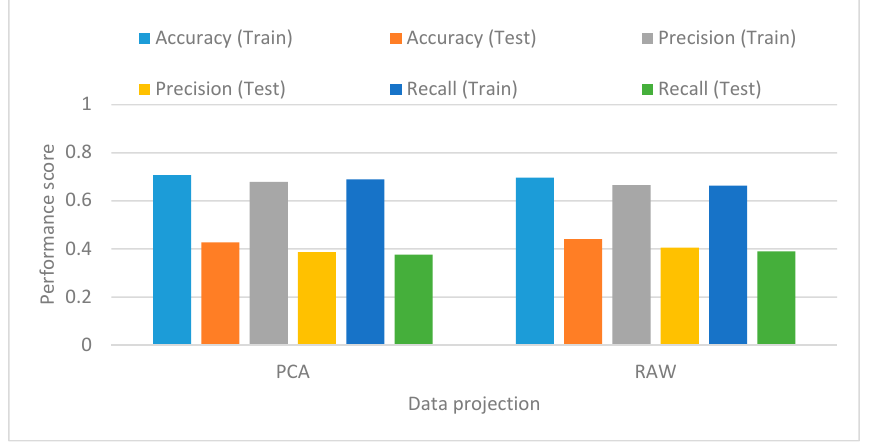
Figure 3. The impact of data projection techniques on performance scores.